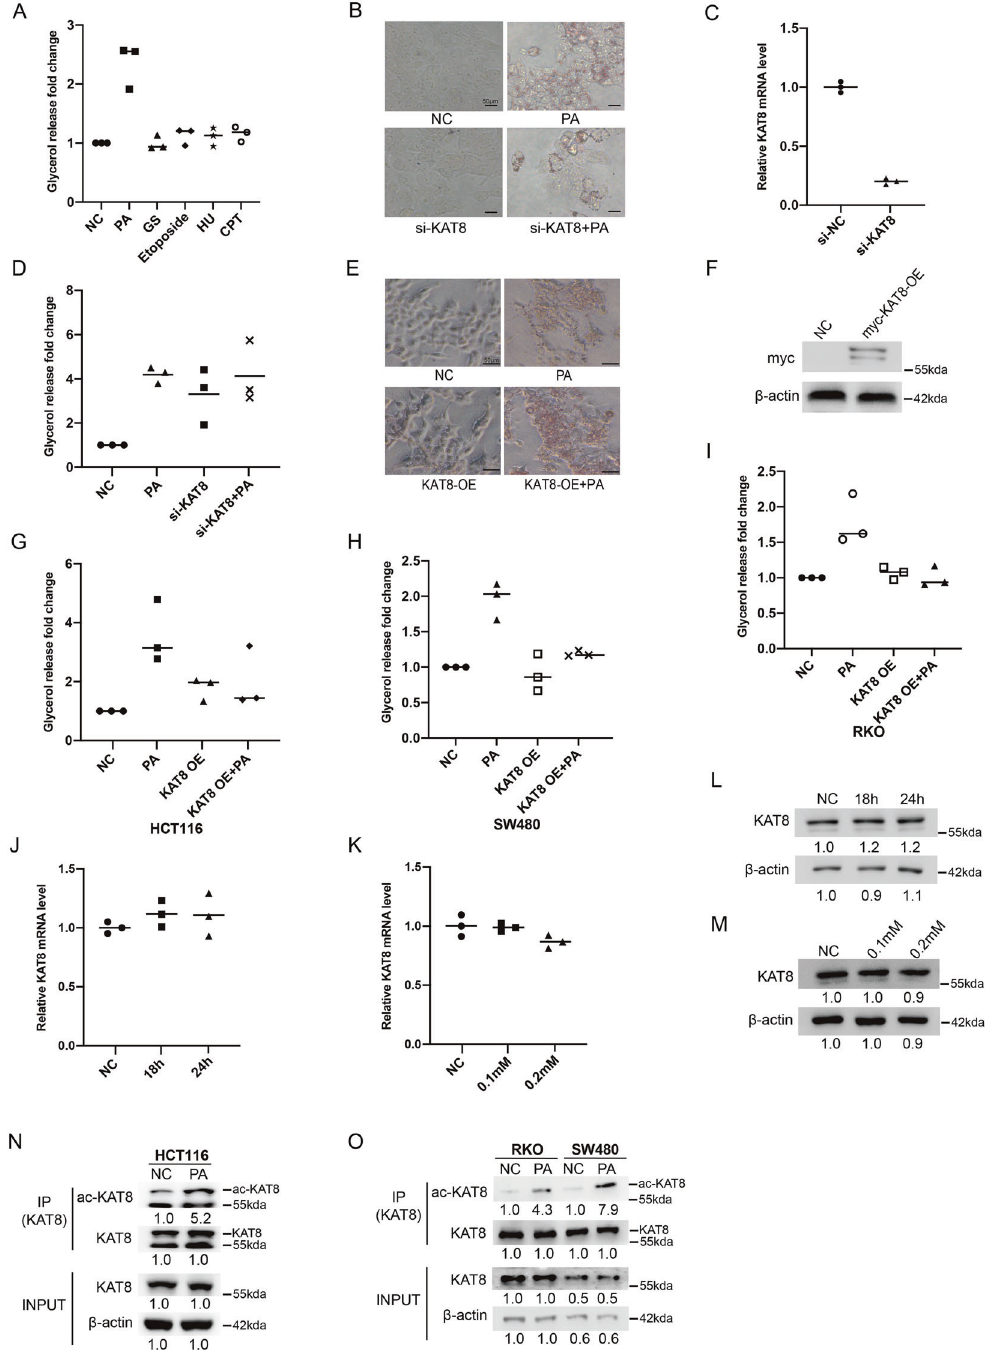
Fig. 1 KAT8 regulates lipolysis accompanied by enhanced KAT8 acetylation after PA treatment in human CRC cells. A HCT116 cells were treated with PA (0.2 mM) for 24 h, glucose starvation (GS) for 18 h, etoposide (40 μ M) for 8 h, HU (2 mM) for 2 h and CPT (1 μ M) for 1 h. Cells were lysed and subjected to quantify the amount of glycerol inside cells by glycerol colorimetric assay kit. B , E HCT116 cells were transfected with KAT8 siRNA (B) or KAT8 plasmid (E), and then treated with or without PA at 0.2 mM for 24 h. Oil red O staining was used to detect the accumulation of lipid droplets. C The siRNA ef fi ciency of KAT8 was detected by real-time PCR. D , G HCT116 cells were treated as outlined above, cells were lysed and subjected to quantify the amount of glycerol inside cells by glycerol colorimetric assay kit. F The transfected ef fi ciency of KAT8 was detected by Western blotting. H , I SW480 (H) or RKO (I) cells were treated as outlined above, cells were lysed and subjected to quantify the amount of glycerol inside cells by glycerol colorimetric assay kit. J , K HCT116 cells were treated with 0.2 mM PA for 0, 18 h and 24 h ( J ) or PA (0.1 mM and 0.2 mM) for 24 h ( K ). The mRNA expression of KAT8 was analyzed by real-time PCR. mRNA levels of the control sample were set as 1, and relative mRNA levels of the experimental samples were normalized to this control. L , M HCT116 cells were stimulated under the same condition above. The total protein expression of KAT8 was detected by Western blotting. β -actin was used as a loading control. N , O HCT116 (N), SW480 and RKO ( O ) cells were treated with or without 0.2 mM PA for 24 h, cell lysates were then extracted for a Co-IP assay to detect endogenous acetylation levels of KAT8 in these cells. The bar ( − ) represents the means ( n = 3).